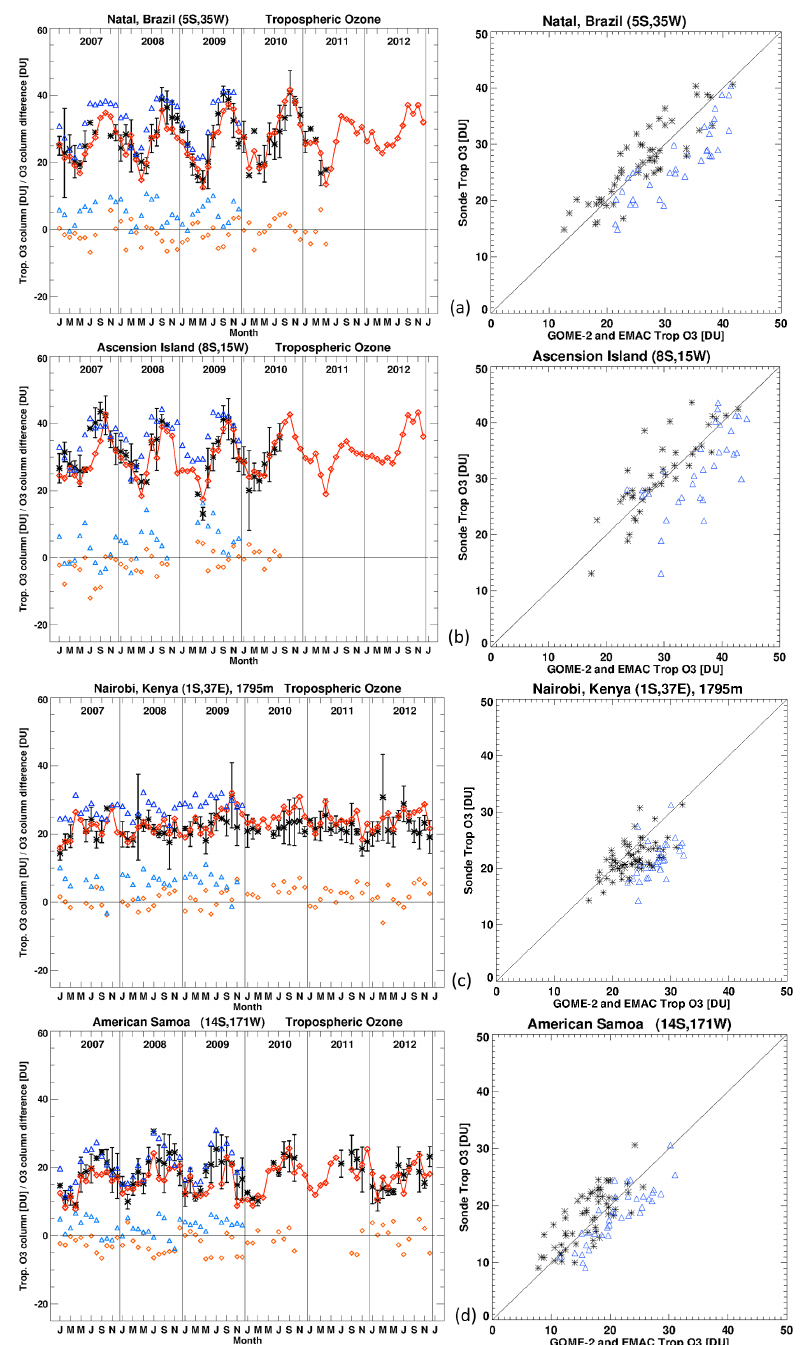
Figure 7. Tropospheric ozone columns for (a) Natal (5 ◦ S, 35 ◦ W), (b) Ascension (8 ◦ S, 14 ◦ W), (c) Nairobi (1 ◦ S, 37 ◦ E) and (d) American Samoa (14 ◦ S, 171 ◦ W) for the period January 2007–December 2012. The asterisks denote the integrated ozonesonde measurements (monthly ensemble average) with 1 σ error bars. The number of individual ozonesonde profiles at the four sites varies between 1 to 5 per month (if there is only one sonde measurement in a particular month, the error bar is omitted). The red diamonds denote the tropospheric ozone columns derived with the GOME-2/CCD method; the blue triangles are tropospheric ozone columns from the EMAC model (see Sect. 7). The small diamonds and triangles show the difference in the ozone columns (GOME-2 – ozonesonde and EMAC – ozonesonde, respectively). Scatter plots of ozonesonde versus GOME-2 (black) and EMAC (blue) monthly mean TOCs for the three sites are shown on the